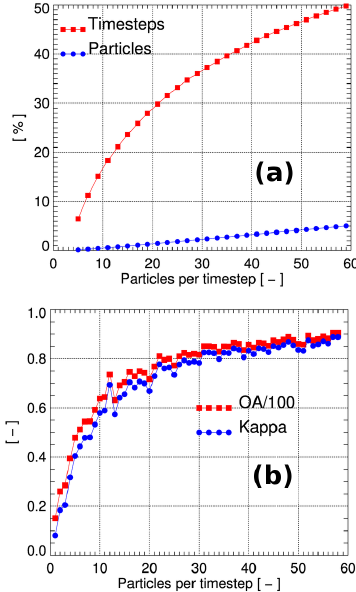
Figure A1. (a) Contributions [%] of time steps of length 1t with less than 60 particles to the total database of observations. (b) Clas- sification performance as a function of the number of particles recorded per time step. Time steps with less than three particles did not contribute to these